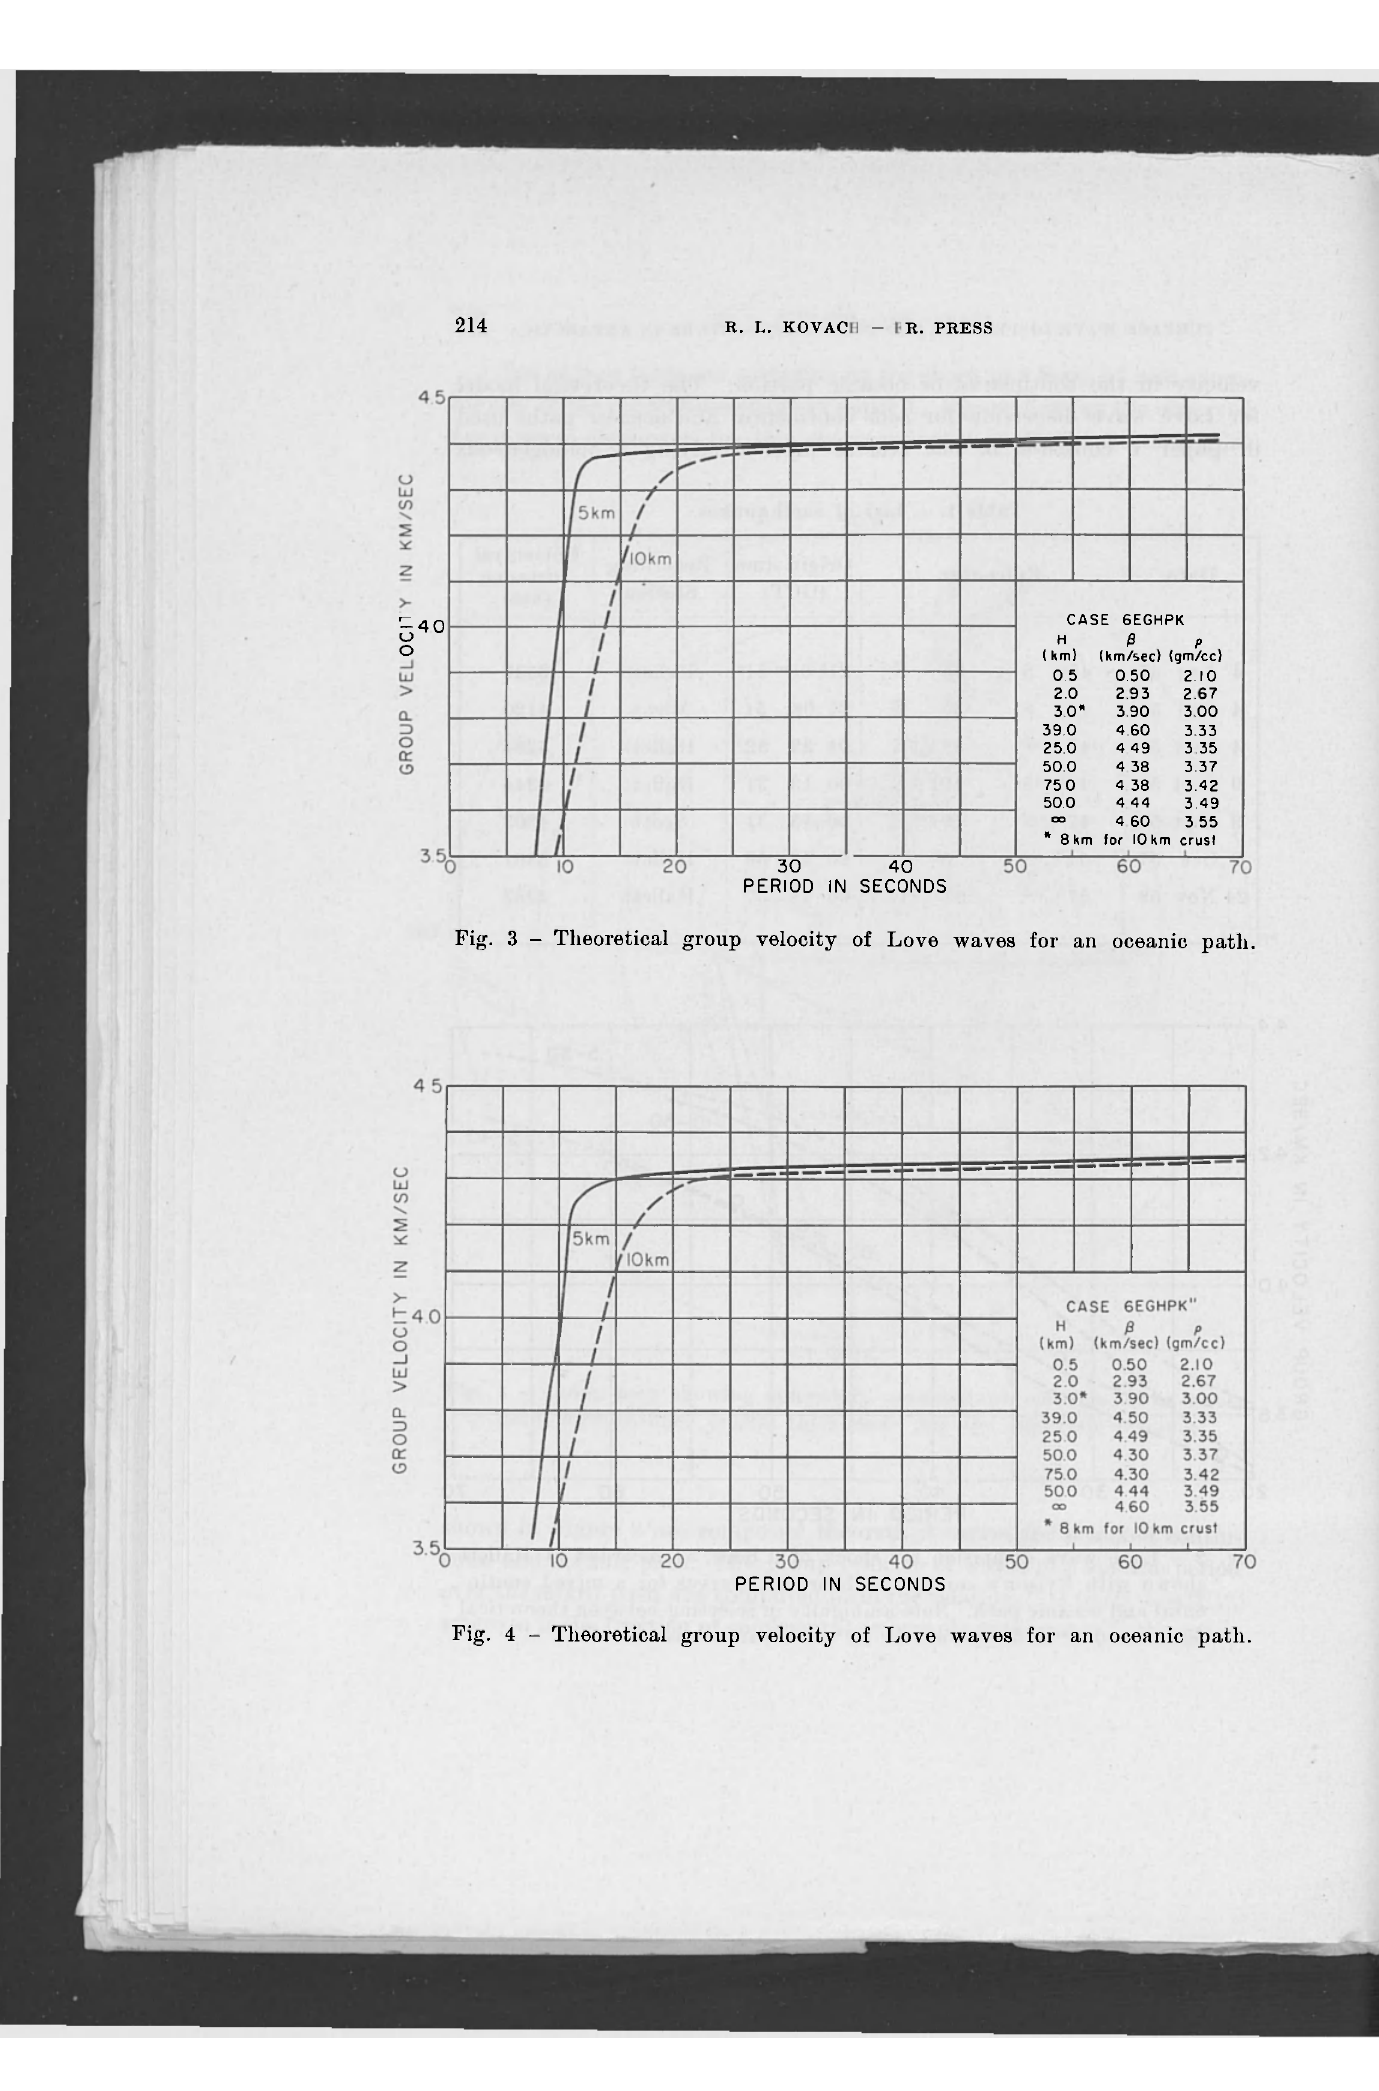
Fig. 3 - Theoretical group velocity of Love waves for an oceanic path.